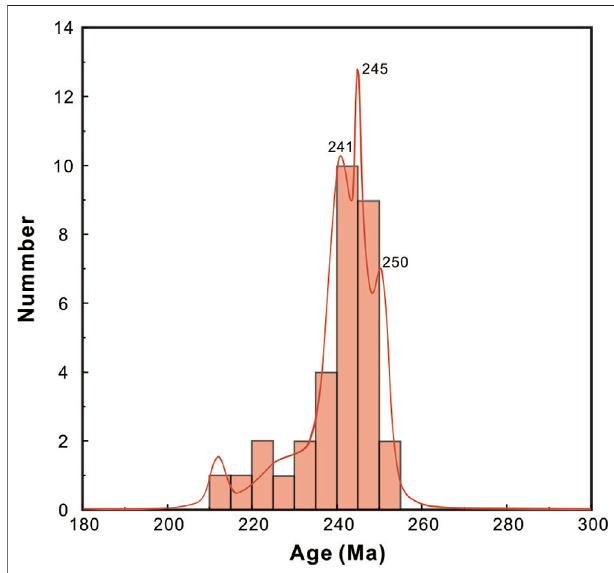
FIGURE 10 | Age data histogram of the Triassic granitic intrusions and related rare metal deposits from the Eastern